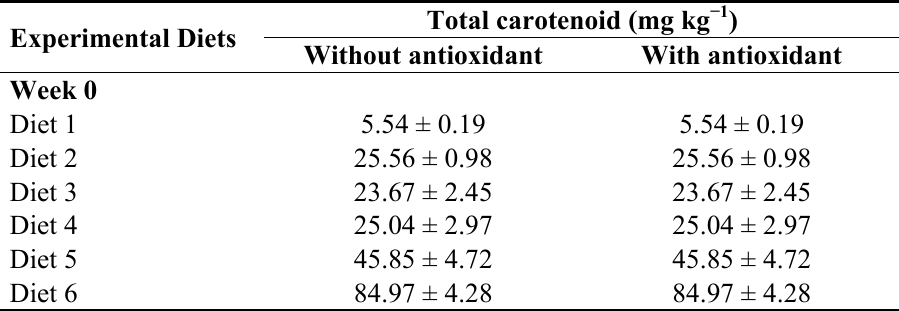
Table 3. Total carotenoids content in the experimental diets storage under room temperature during the trial